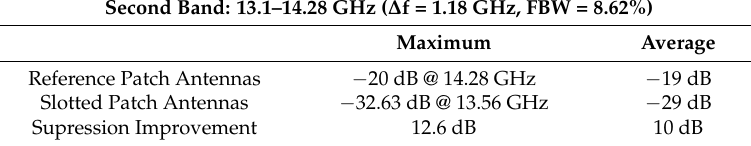
Table 2. Isolation in the first Ku-band.